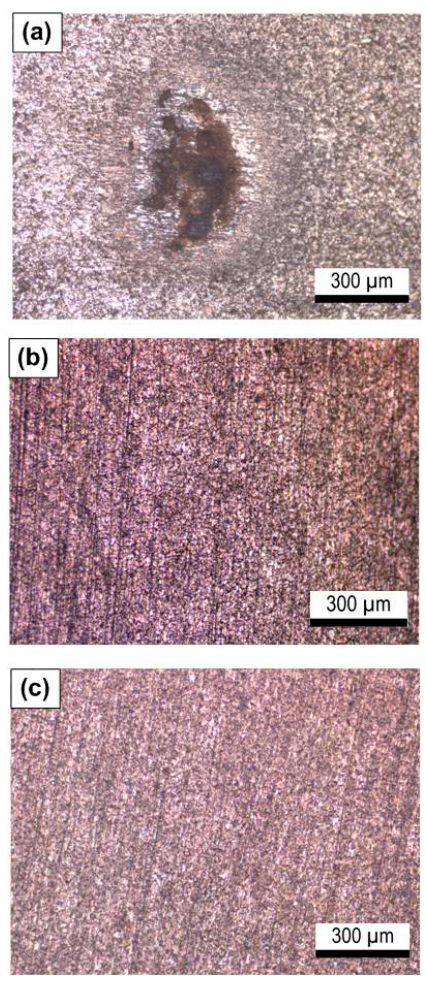
Figure 7. Optical microscope images of the specimens covered with ( a ) α -FeOOH, ( b ) Fe 3 O 4 and ( c ) Fe 2 O 3 iron oxide deposits, after potentiostatic tests under − 650 mV SCE for 20 h in the simulated district heating water at 40 °C.